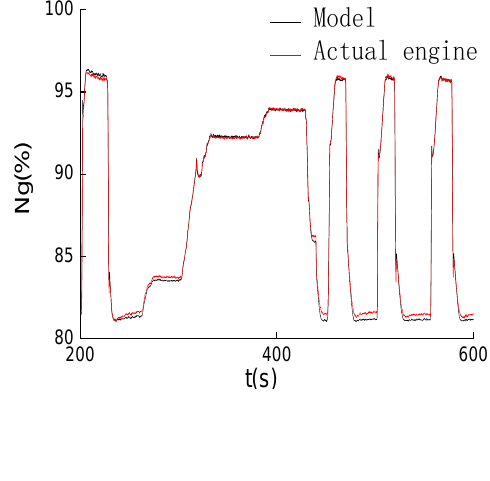
by the model and turbo-shaft g